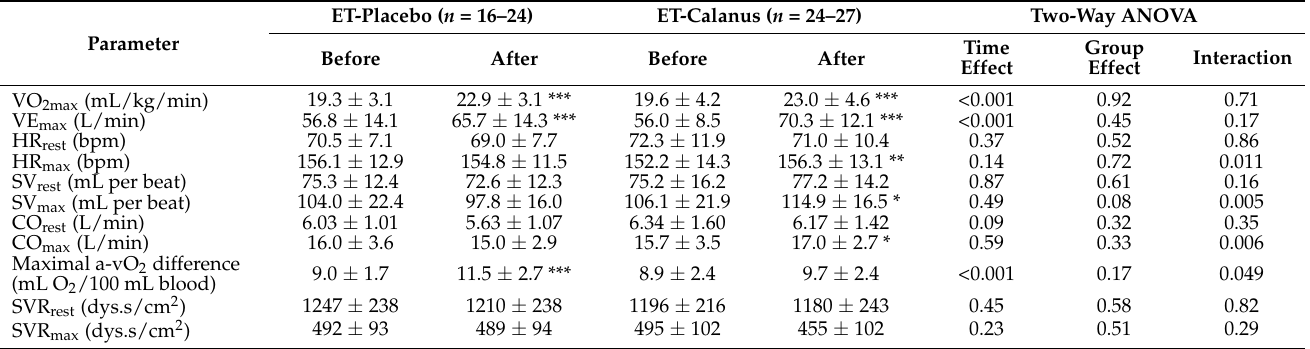
Table 4. Cardiovascular and ventilation parameters of participants before and after the